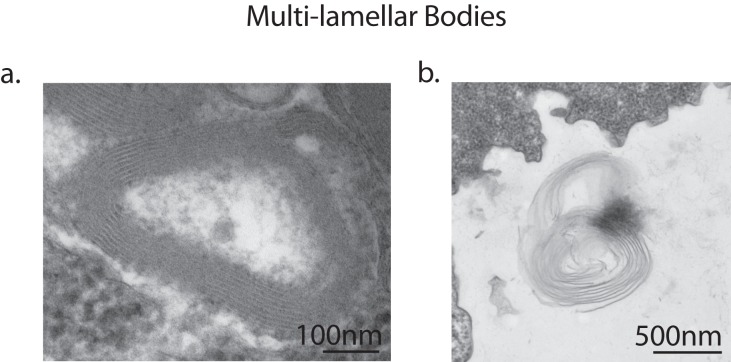
Multi-lamellar bodies excreted by vegetative amoebae.Transmission electron micrographs of vegetative amoebae identified multi-lamellar bodies inside uninfected amoebae, indicating successful digestion of bacterial food (a). Multi-lamellar bodies are eventually secreted into the surrounding medium (b).